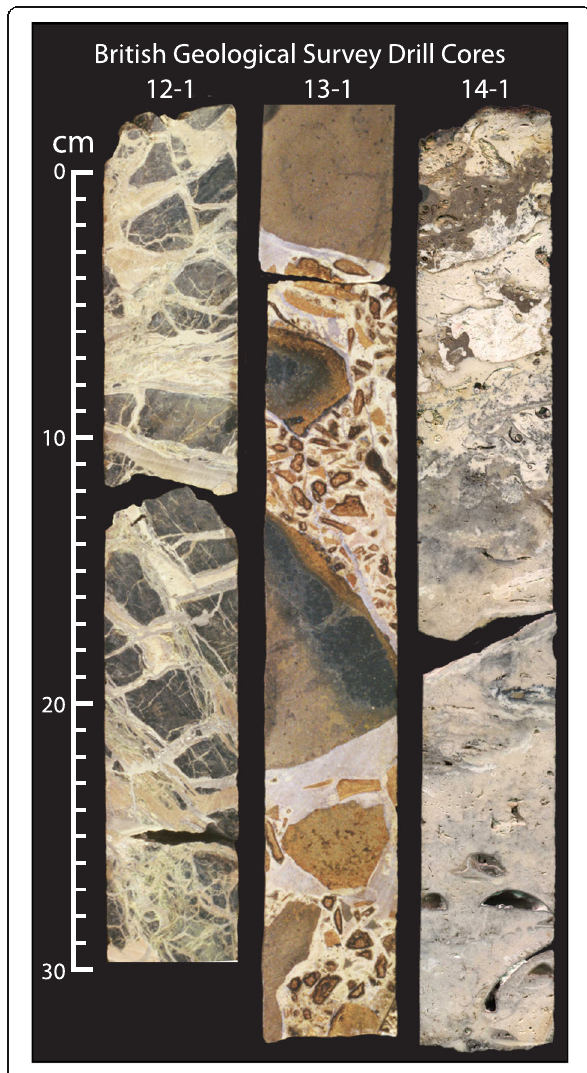
Fig. 6 British Geological Survey diamond drill cores from the Atlantis Bank wave-cut platform documenting the presence of: 12-1 - carbonate veined serpentine ophicalcite in the eroded fault